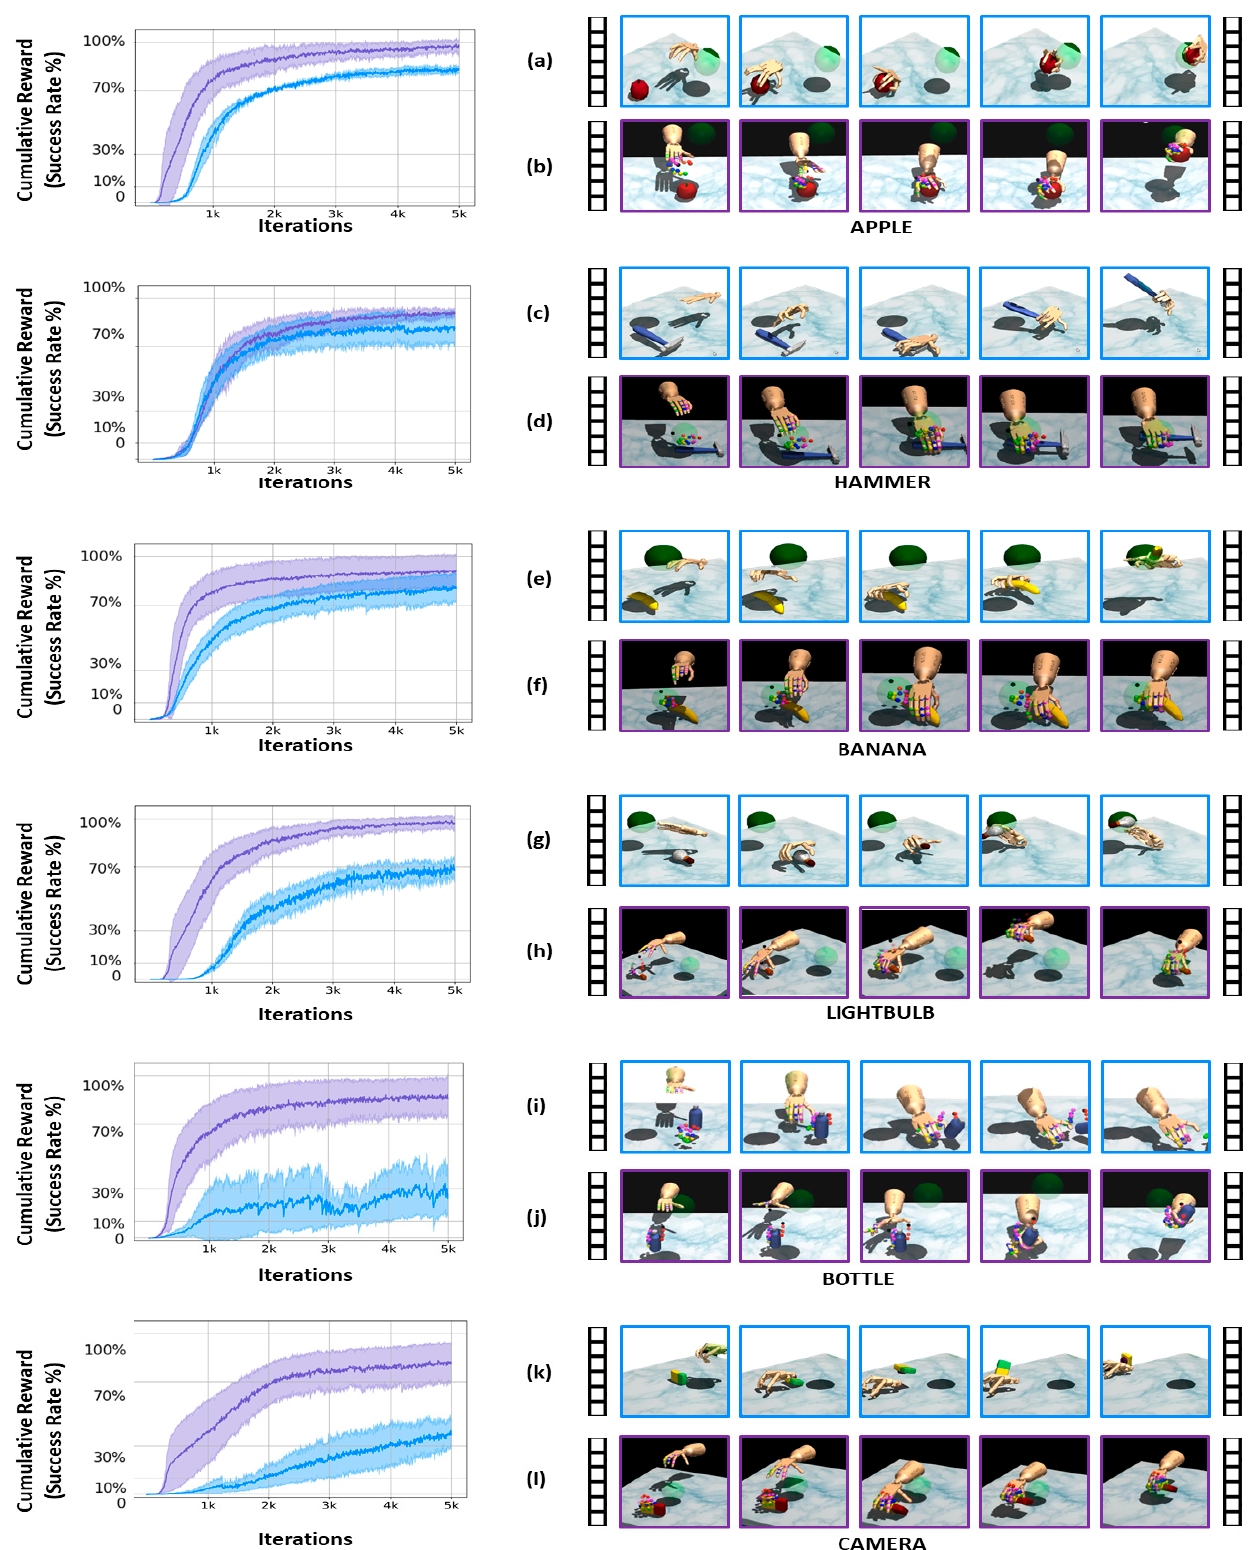
Figure 4. On the left, the average sum of rewards for object manipulation by NPG (blue, top) and T-DRL (purple, bottom). On the right, the evaluation time-series frames from grasping and relocation of each object using the best policies of NPG (blue, top) vs. T-DRL (purple, bottom) for apple ( a ) vs. ( b ), hammer ( c ) vs. ( d ), banana ( e ) vs. ( f ), light bulb ( g ) vs. ( h ), bottle ( i ) vs. ( j ), and camera ( k ) vs. ( l ).